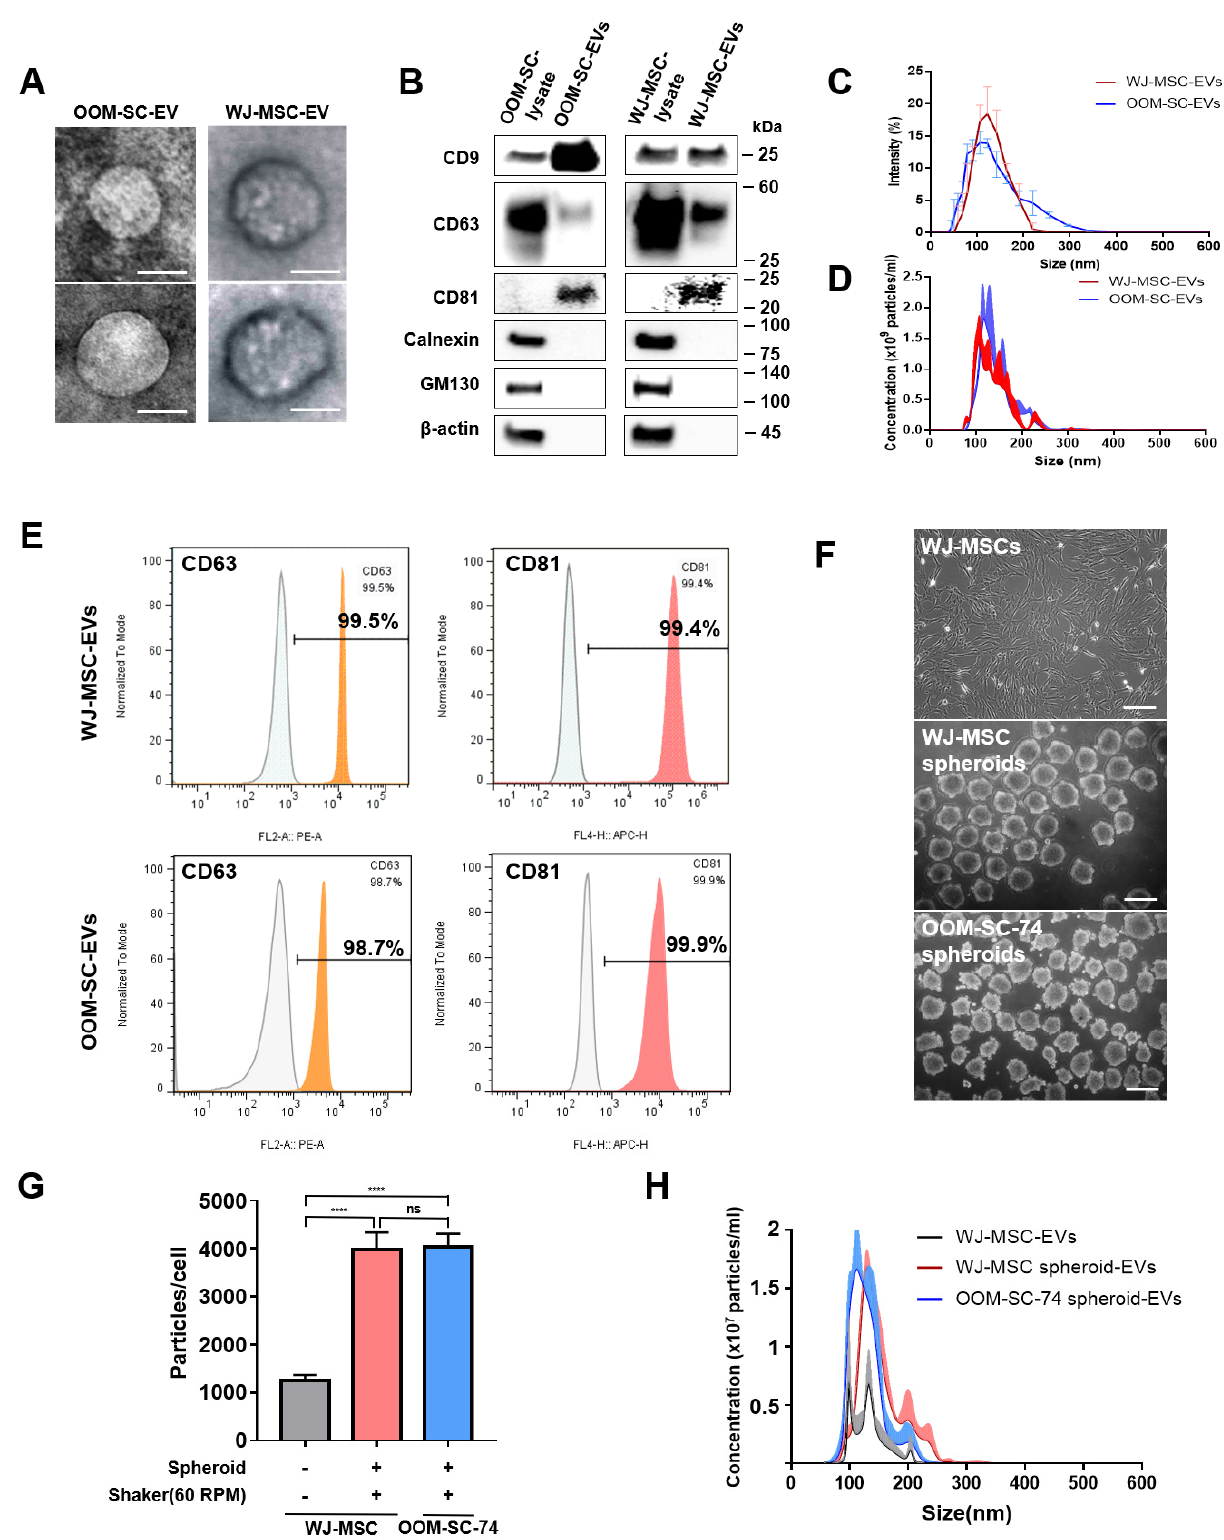
Figure 3. Characterization of OOM-SC-EVs. ( A ) TEM images of EVs showing cup- or sphere-shaped morphology. TEM analysis was performed at 80 kV. Scale bar = 100 nm. ( B ) Characterization of the expression levels of the EV-associated positive surface markers, including CD9, CD63, CD81, calnexin, and GM130, via immunoblotting. We used 3 µ g of EVs for the immunoblotting analysis. The protein expression levels of the EV markers were compared with those of the whole cell lysate. ( C ) Dynamic light scattering analysis of EVs sizes. The average diameter of the purified EVs was of a size range of